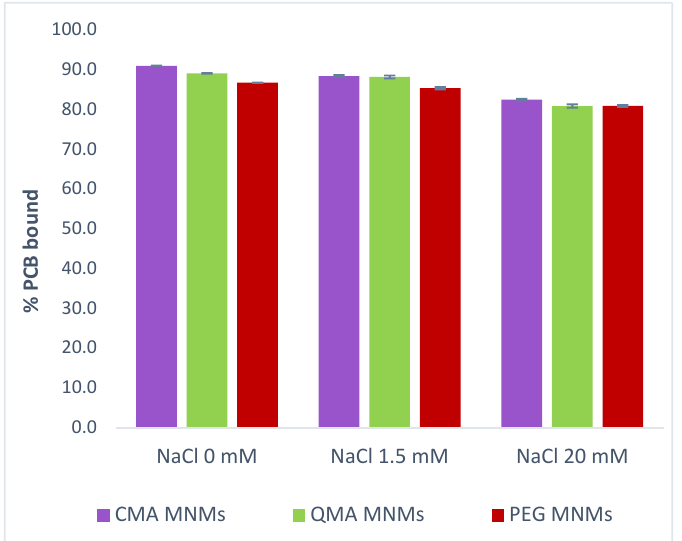
Figure 2. Effect of ionic strength on the sorption efficiency of PCB 126 on CMA MNMs, QMA MNMs, and PEG MNMs. The ionic strength concentrations represent fresh water (0 mM), surface water (1.5 mM), and ground water (120 mM).